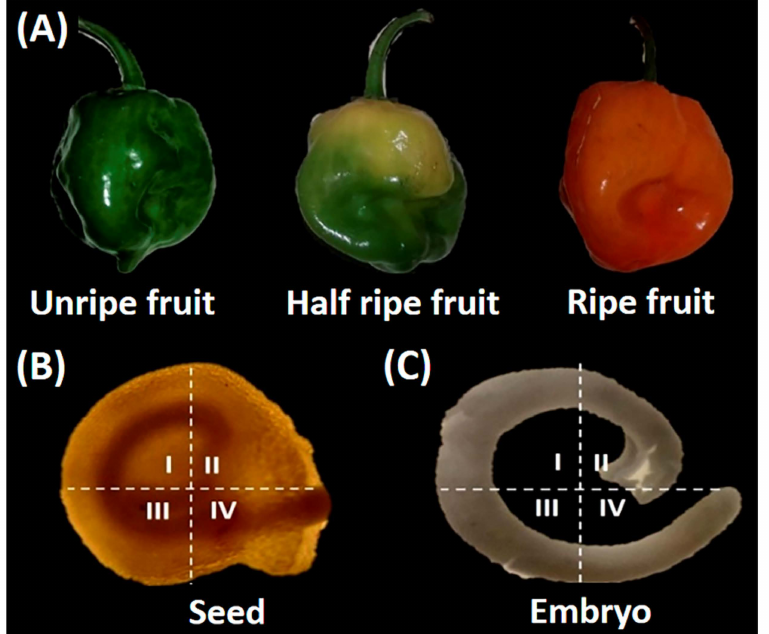
Figure 1. ( A ) Maturity stages of the habanero pepper fruit. ( B ) Complete seed divided into the central region of the micropyle and ( C ) habanero pepper embryo, quadrants I (hypocotyl), II (cotyledons), III (hypocotyl-radicle), and IV